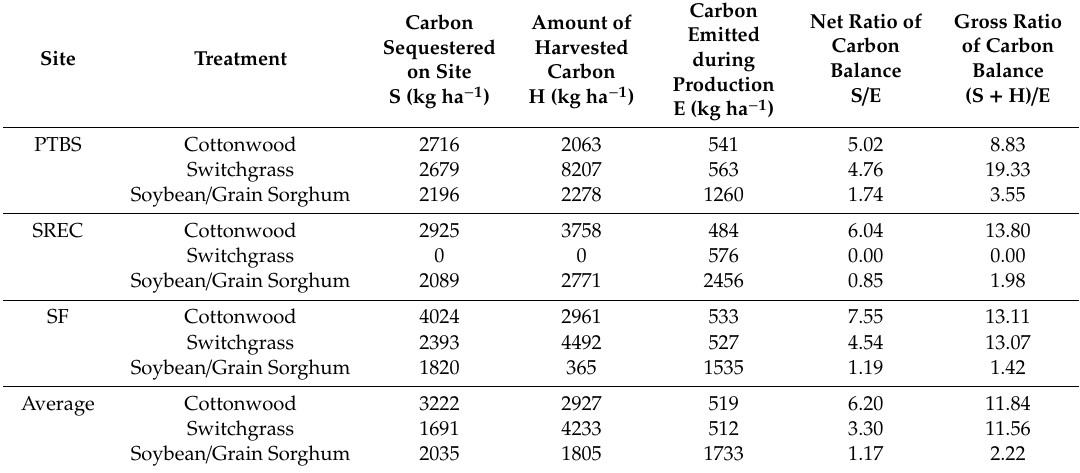
Table 5. Total C sequestered, amount of harvested carbon, total carbon emitted, and the net and gross ratio of carbon e ffi ciency after three years for each site and